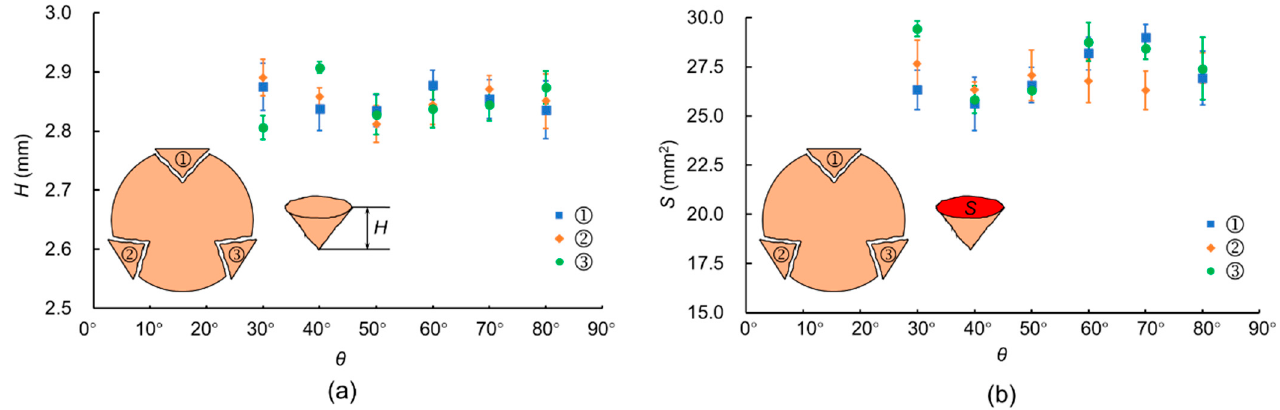
Figure 9. Statistical results of the conical core sizes: ( a ) height of the conical core and ( b ) bottom area of the conical core. Each result is an average of three repeated tests with a criterion error. The conical cores caused by Particles II, III, and IV are numbered ① , ② , and ③ .